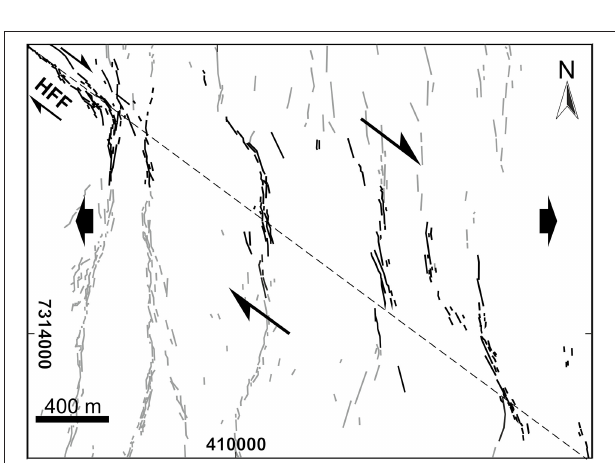
FIGURE 6 | Plot of the segments of tension fractures and faults of the TFS that do not have the typical N00 to N20 ◦ orientation. These segments depict a corridor where the fractures strike exactly as the easternmost strands of the HFF (N330–N340 ◦ ), with an overall pattern that is consistent with the earlier stages of development of a transtensional right-lateral fault system (modified after Tibaldi et al.,